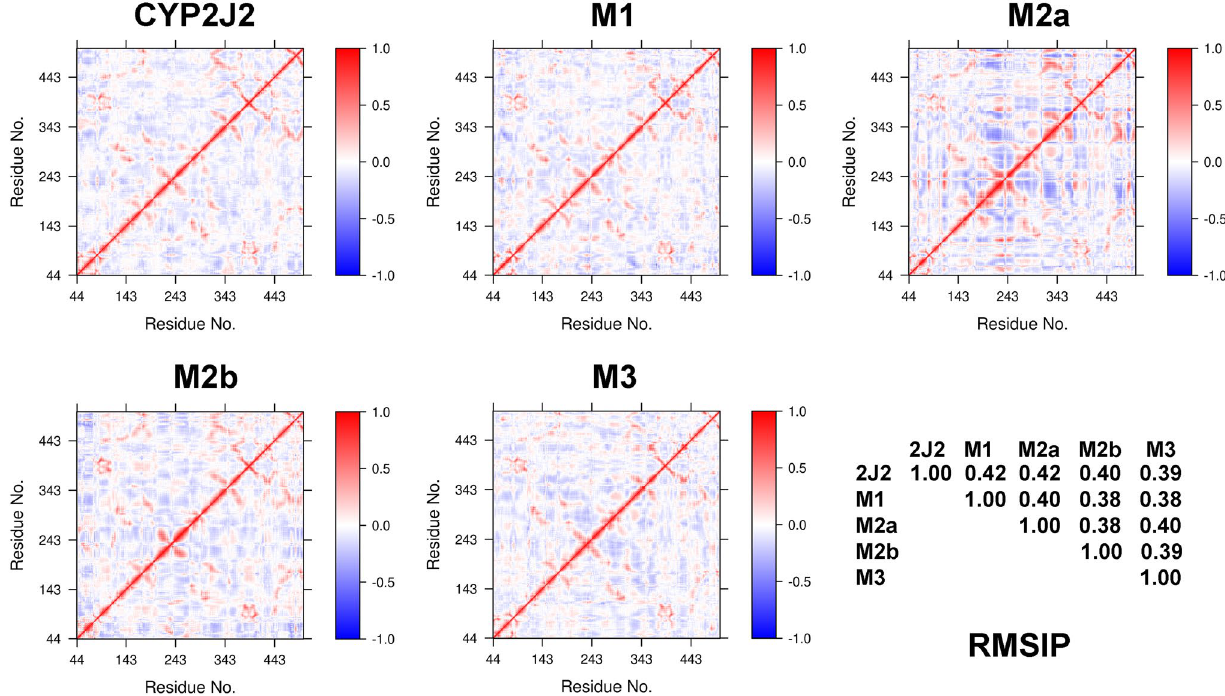
Figure 8. The dynamical cross-correlation maps (DCCMs) for the free and M1 / M2 / M3 -bound CYP2J2. The root mean square inner product (RMSIP) between any two different systems was also calculated. M2a and M2b denote initially extended and folded conformation of M2 , respectively. This figure was rendered using Bio3D 37